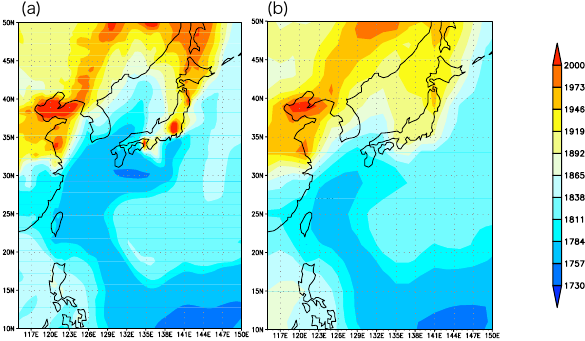
Fig. 11. Simulated surface CH 4 concentrations (ppb) around Japan at 13:00JST on 6 July 2008 with a horizontal resolution of (a) 0.5 ◦ and (b) 2.0 ◦ .